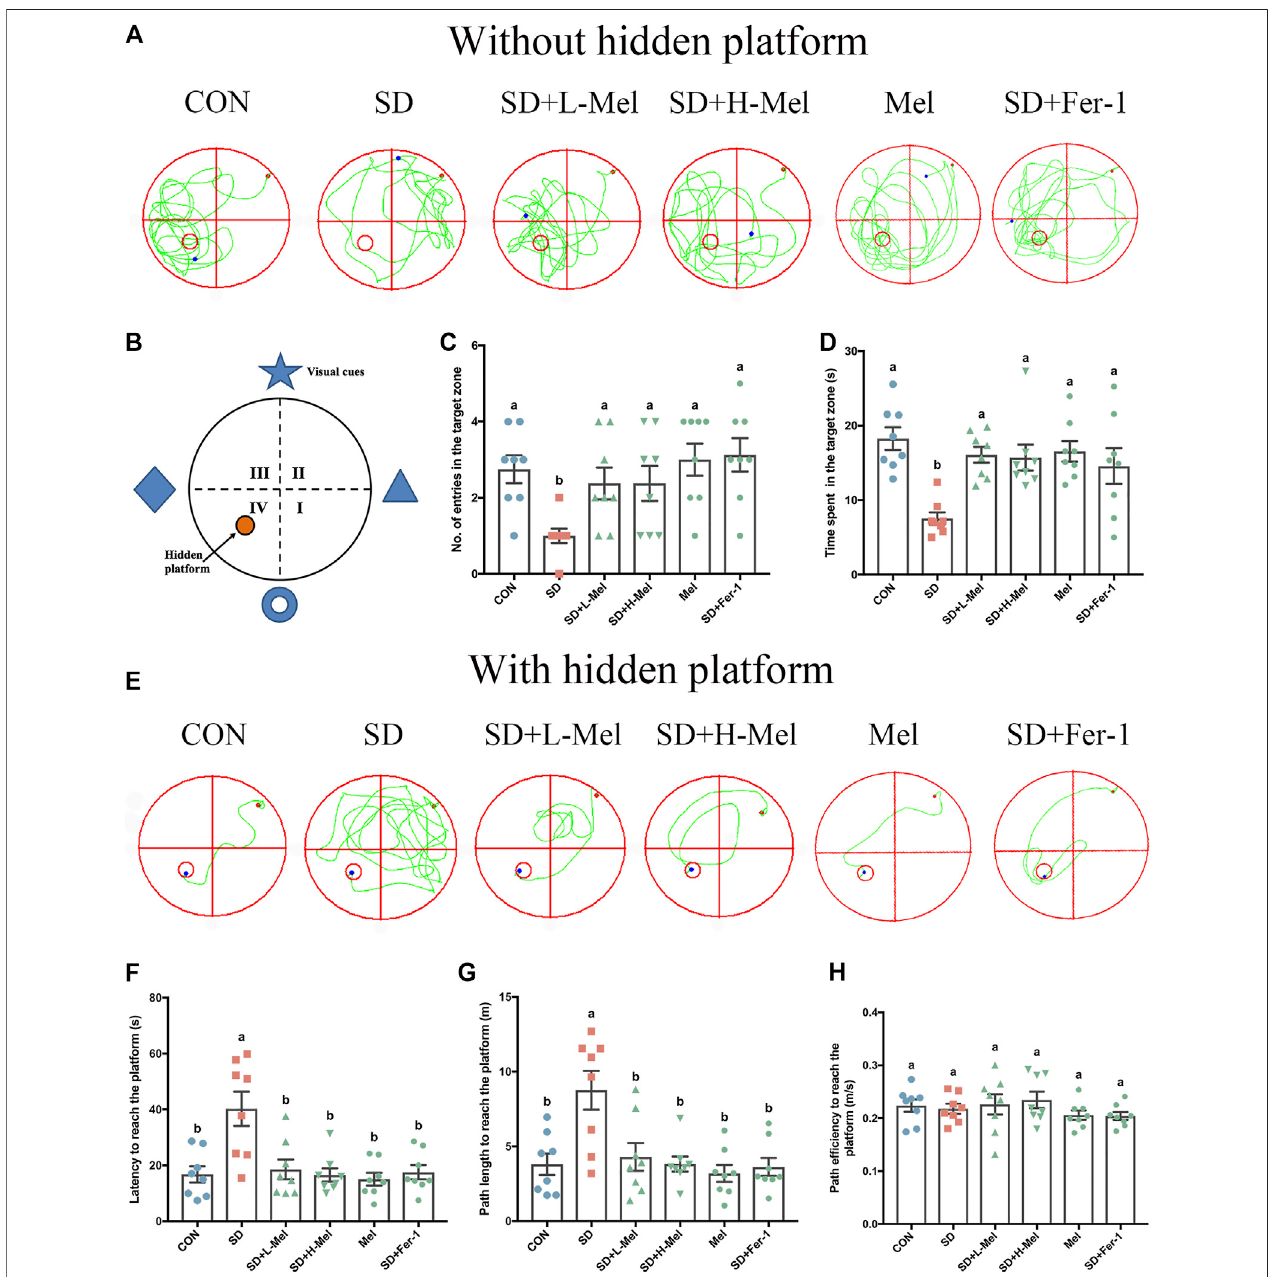
FIGURE 2 | Effect of melatonin on ability of learning and memory in sleep-deprived mice. (A) Track plot of spatial memory test (without hidden platform). (B) SchematicoftheMorriswatermaze. (C) Numberofentriesintothetargetzone( n (cid:1) 8). (D) Timespentinthetargetzone( n (cid:1) 8). (E) Trackplotofspatialmemorytest(with hidden platform). (F) Latency to reach the platform ( n (cid:1) 8). (G) Path length to reach the platform ( n (cid:1) 8). (H) Path velocity to reach the platform ( n (cid:1) 8). Differences were assessedusingone-wayANOVA.Theresultrepresentsthemean ± standarderrorofthemean.Valuesnotsharingacommonsuperscriptletterdiffersigni fi cantlyat p < 0.05; those with the same letter do not differ signi fi cantly ( p ≥ 0.05). CON: control group, SD: sleep deprivation group, SD + L-Mel: SD + low melatonin (20 mg/kg) supplement group, SD + H-Mel: SD + high melatonin (40 mg/kg) supplement group, Mel: melatonin (20 mg/kg) supplement group, SD + Fer-1: SD + Fer-1 (1 mg/kg) supplement